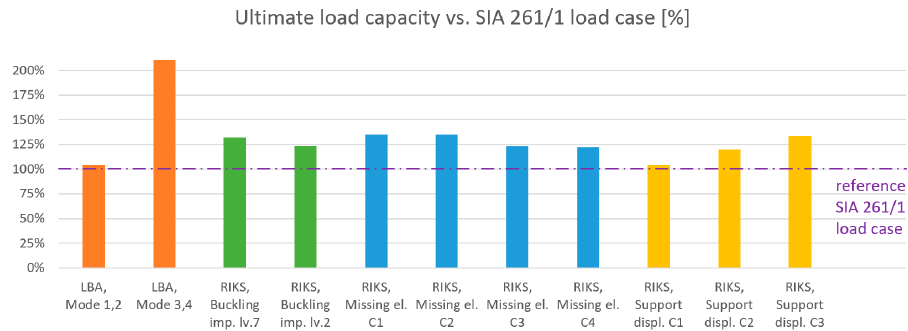
Figure 26. Ultimate load-bearing capacity in LBA and RIKS analysis versus the design load case from SIA 261/1 as a reference.